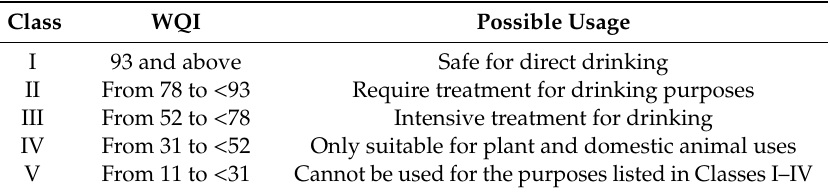
Table 1. National water quality standards (NWQS) for Malaysia [7]. Class WQI Possible